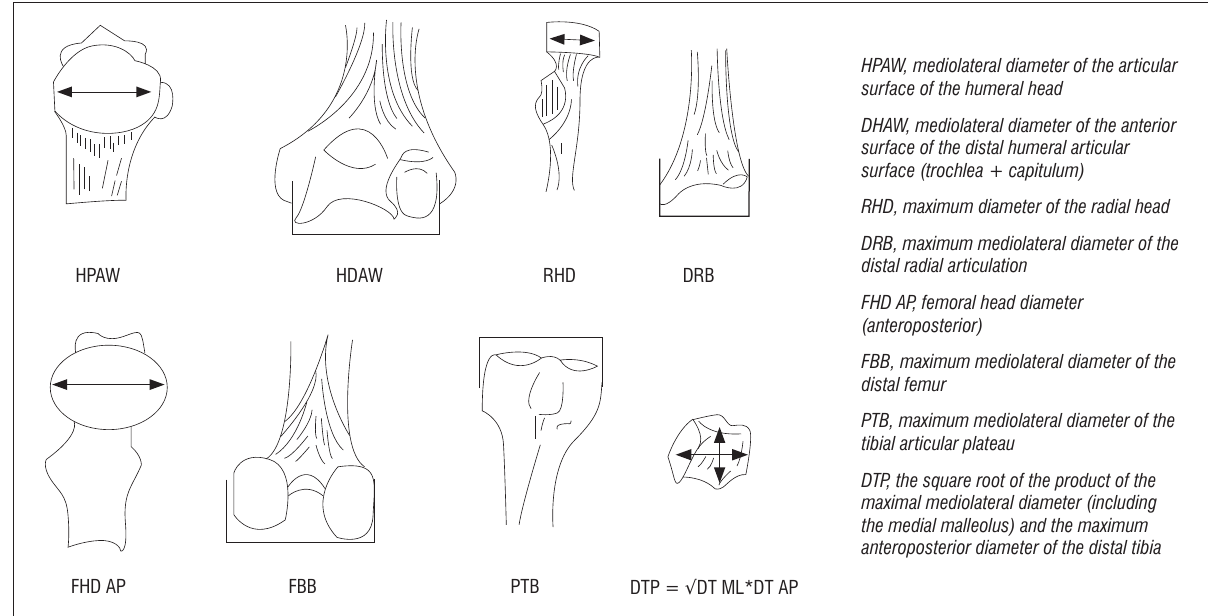
Figure 1: Linear variates taken on associated fore- and hindlimb epiphyses used in the derivation of the size metric